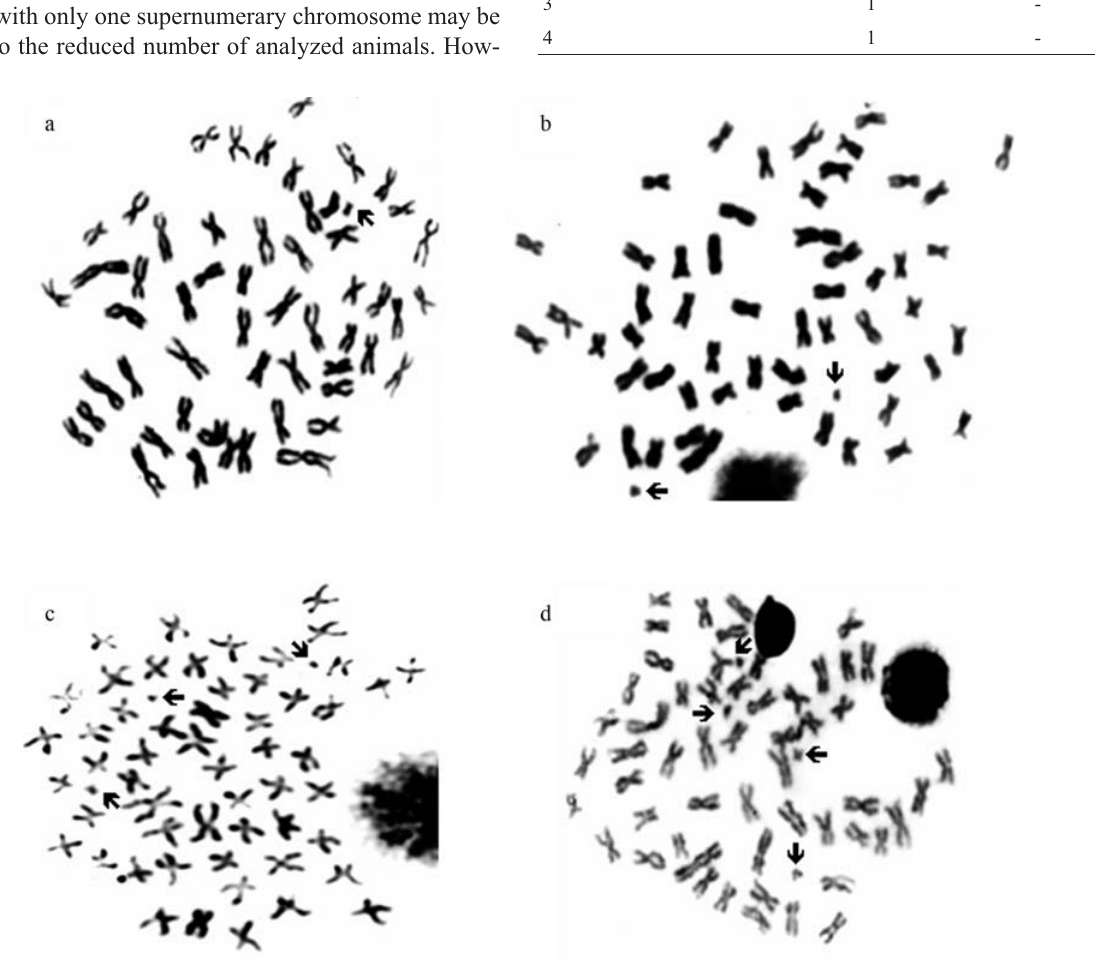
Figure 1 - Giemsa-stained metaphases of Cyphocharax modestus from the Paranapanema River evidencing (a) one supernumerary chromosome, (b) two supernumerary chromosomes, (c) three supernumerary chromosomes, and (d) four supernumerary chromosomes.